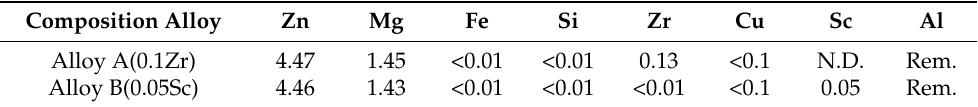
Table 1. The composition of the experimental alloy (wt%).